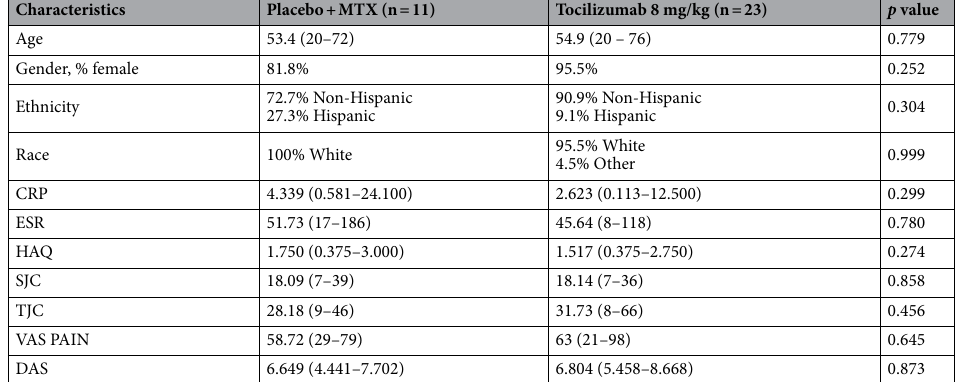
Table 3. Demographic characteristics for placebo and treated patients of the subset. Categorical variables are described as percentages, while continuous variables as means (range) and were compared between the two groups (placebo and treated) with Mann–Whitney test. P values are shown in the last column. Statistical significance is considered as * P < 0.05, ns = P > 0.05. CRP: C-reactive protein, ESR: erythrocyte sedimentation rate, HAQ: health assessment questionnaire, SJC: swollen joint count, TJC: tender joint count, VAS: visual analogue scale, DAS: disease activity